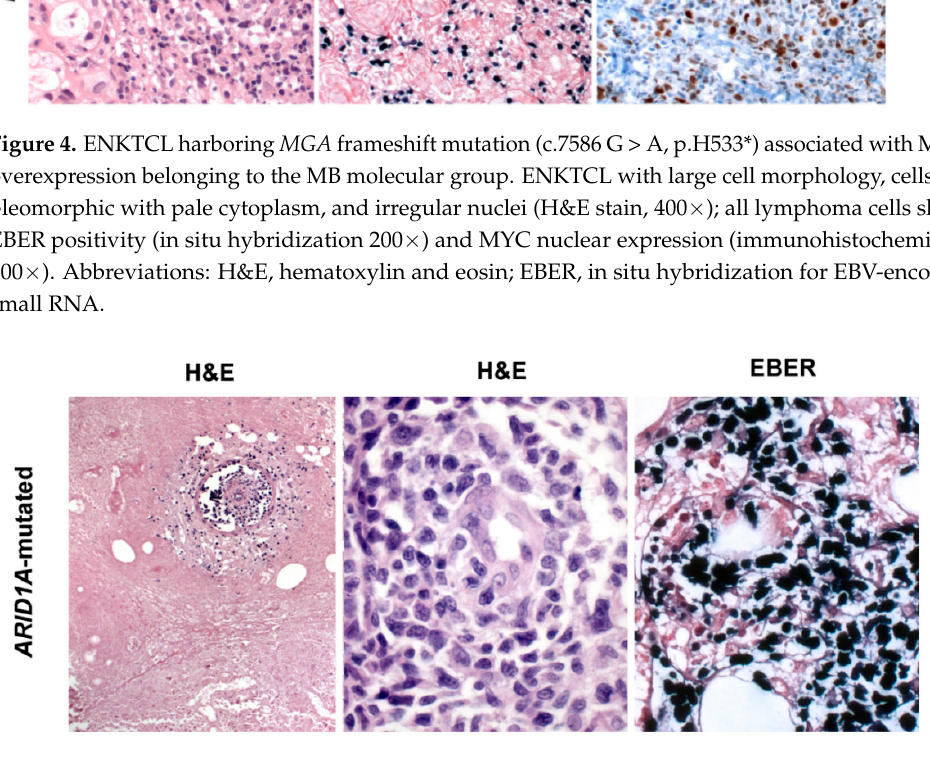
Figure 5. ENKTCL harboring ARID1A mutation probably belonging to the HEA molecular group. The morphological hallmark features of ENKTCL are present: coagulative necrosis and large-size pleomorphic neoplastic cells leading to angioinvasion (H&E stain, 200× and 400×). All lymphoma cells show EBER positivity (in situ hybridization, 400×). This case carried also a DDX3X missense mutation (c.1537G>C, p. V513L). Abbreviations: H&E, hematoxylin and eosin; EBER , in situ hybridization for EBV-encoded small RNA.